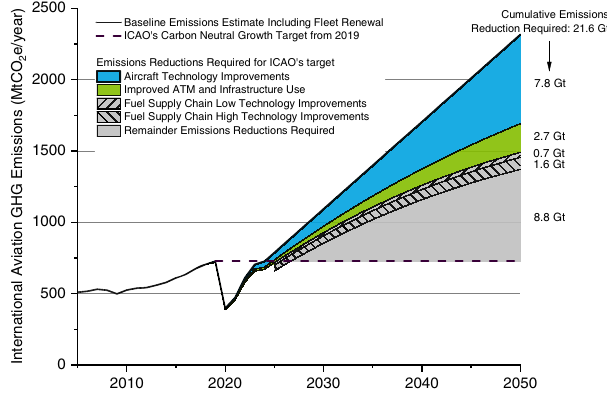
Fig. 4 | Well-to-wake GHG emissions and reductions potential from interna- tional aviation 2019-2050. Only international aviation is considered. Jet fuel consumption data are from IEA (2005-2024) 32 and International Civil Aviation Organization (ICAO, 2050) 4 . The original IEA data includes domestic and interna- tional consumption; therefore, a 57% share is calculated for the international por- tion based on the 2017 record and assumed for the whole period. The base